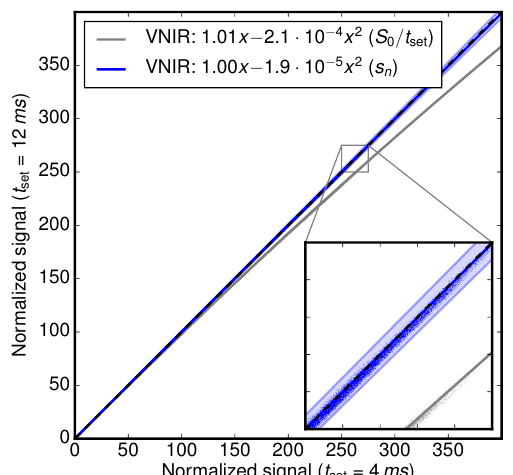
Figure 8. Integration time-normalized signal S 0 /t set (gray line) of the stabilized light source (LIS), measured with the SWIR using two different integration times t set = 0 . 3ms and t set = 3 . 2ms. The red line shows the signal after normalization ( s n ) using the corrected integration time t set + 0 . 055ms. The dashed line represents the re- sponse of a perfectly linear sensor following Eq.